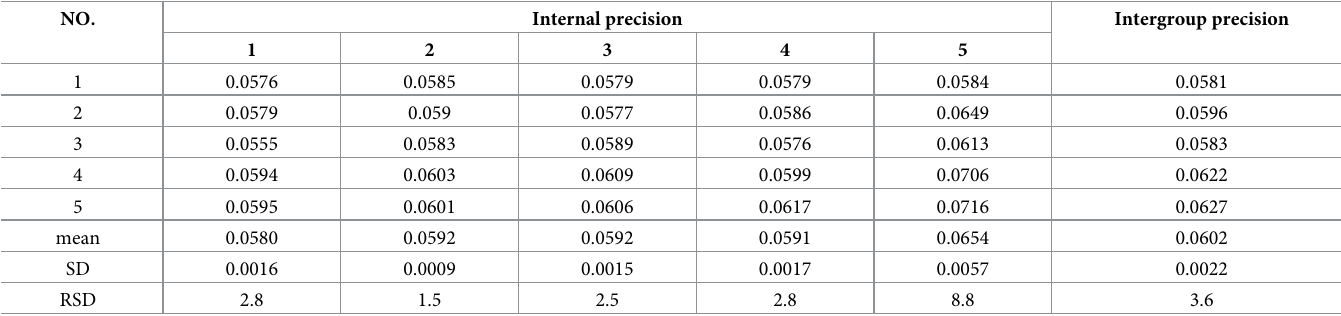
Table 2. Internal precision and intergroup precision of hair